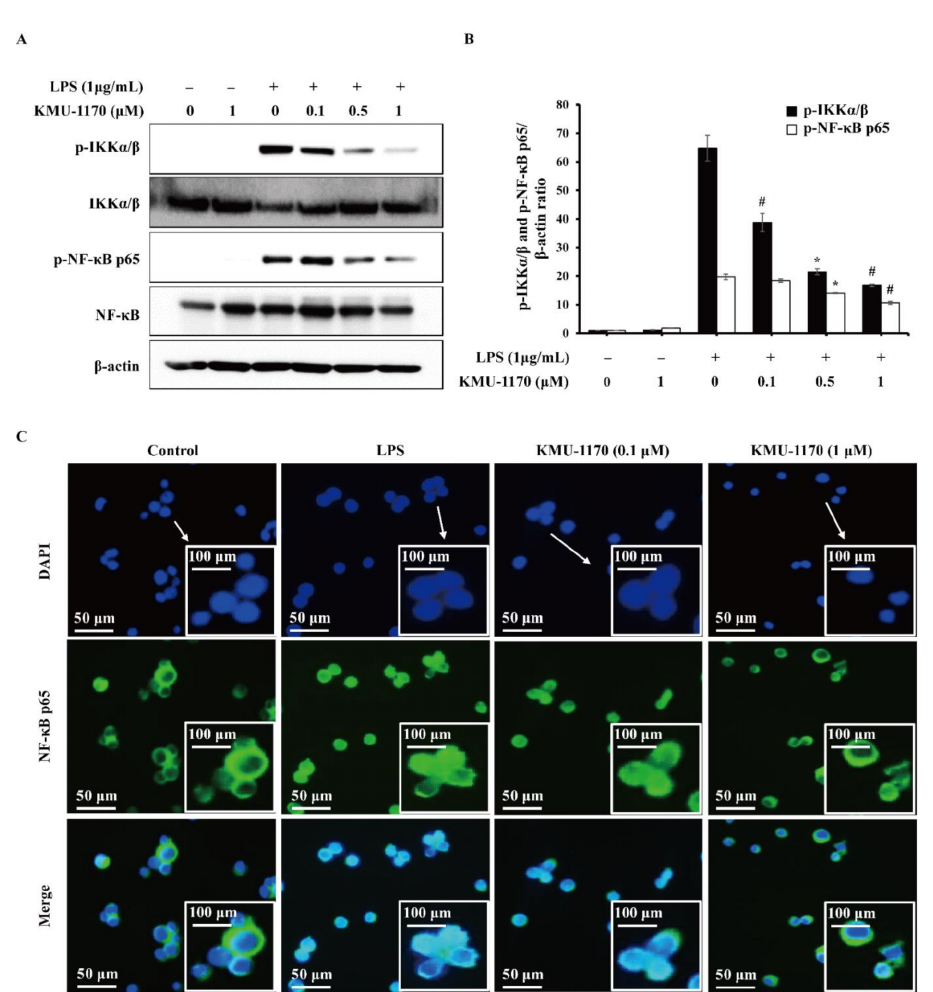
Figure 4. Inhibitory effect of KMU-1170 on LPS-induced phosphorylation of IKK α / β and NF- κ B, and nuclear translocation of NF- κ B in THP-1 cells. Cells were differentiated into macrophages for 24 h using PMA (100 nM). And then the cells were treated with LPS (1 µ g/mL) for 6 h after pretreatment with the indicated concentrations of KMU-1170 for 1 h. ( A ) Whole cell lysates were isolated and used to measure the protein expression levels of p-IKK α / β , IKK α / β , p-NF- κ B p65, NF- κ B p65, and β -actin by Western blot analysis. ( B ) Image-J software was used to analyze the relative optical density of the p-IKK α / β and p-NF- κ B p65 band. ( C ) Cells were stained with antibodies to the NF- κ B p65 ( green ) and 4 (cid:48) ,6-diamidino-2-phenylindole ( blue ) and captured at × 200 using fluorescence microscope. Arrows indicate 400 times magnification. * p < 0.01 and # p < 0.001 compared to LPS